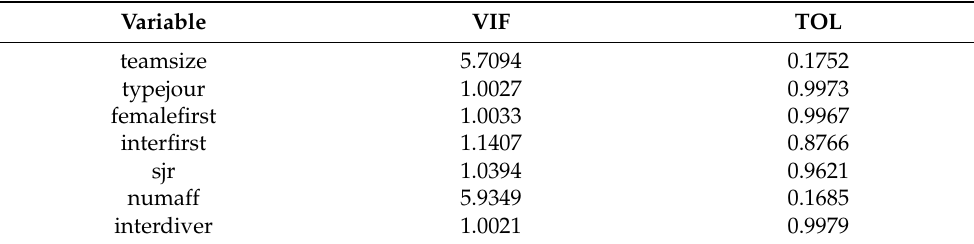
Table 6. The statistical values of Variance Inflation Factor (VIF) and Tolerance